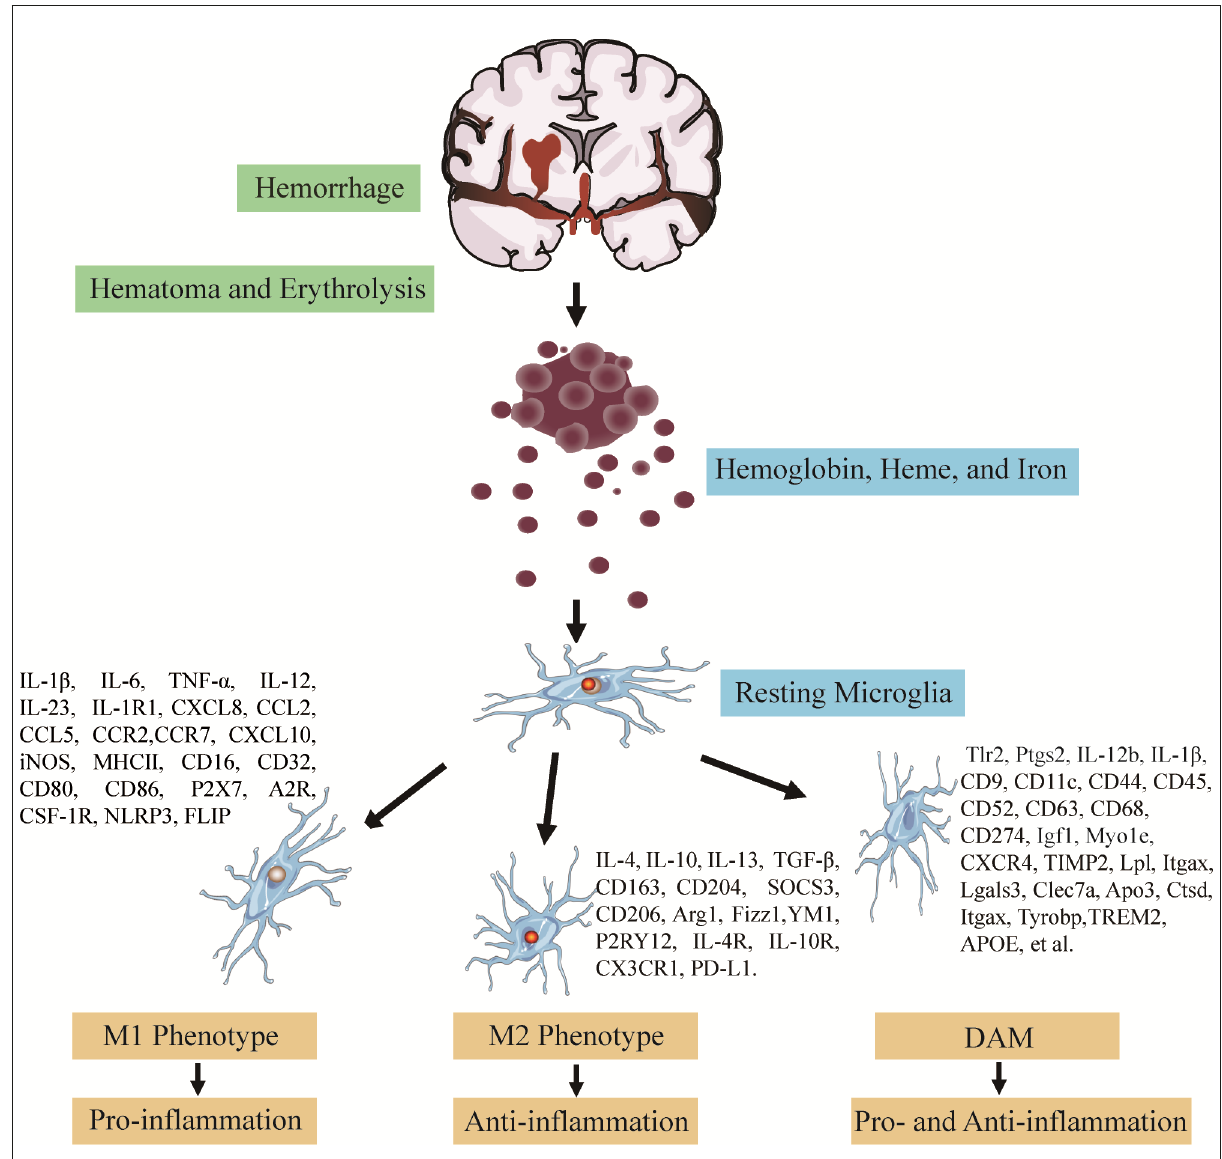
FIGURE1 Polarization of activated microglia following intracerebral hemorrhage (ICH). The polarization of activated microglia in response to stimulation with erythrocyte lysates after ICH can be broadly classified into three categories. Each category has its related cytokines, chemokines, and surface markers: (1) pro-inflammatory microglia elevate the pro-inflammatory factors and destruc tive effects on the brain; (2) anti-inflammatory microglia mainly exert neuroprotective effects; (3) disease-associated microglia (DAM). Recent, an increasing number of studies by single-cell RNA-sequence and Various other omics methods have revealed that microglia can also be polarized into neuroprotective and neurodestructive phenotypes, remaining to be further